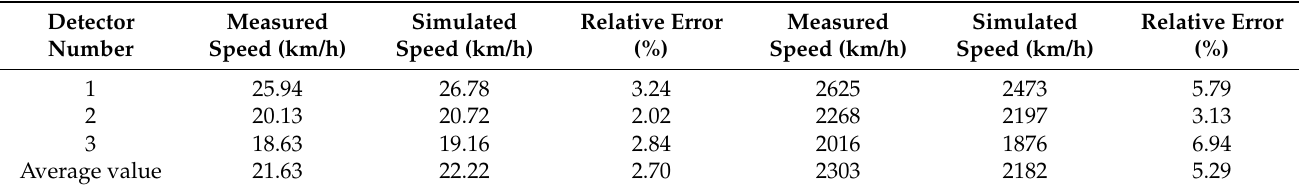
Table 2. Verification results of simulation model in congested flow